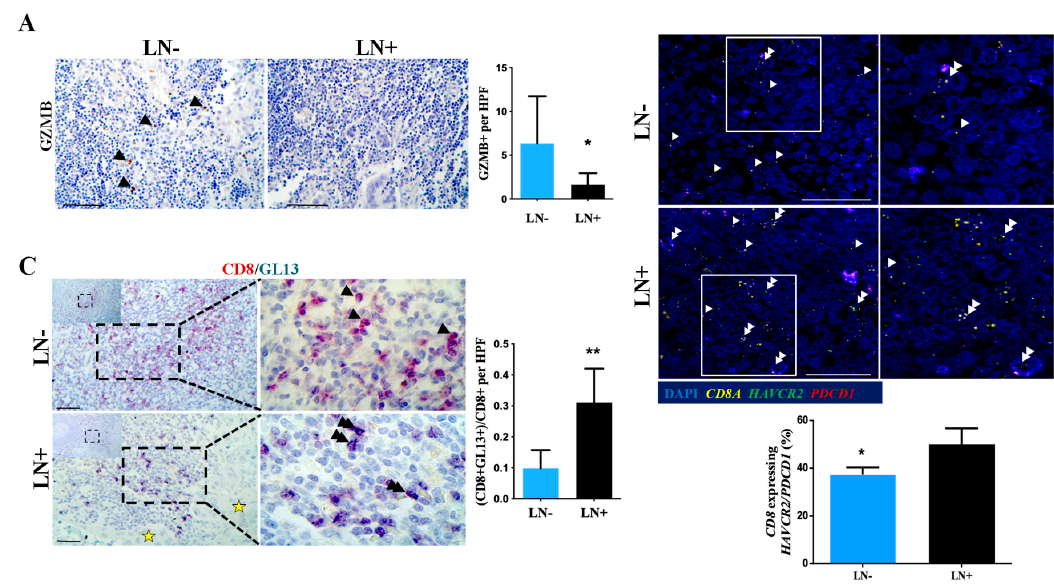
Figure 5. T cells in positive draining lymph nodes exhibit features of T cell exhaustion and senescence. ( A ) Left panel: representative micrograph of GZMB immunohistochemical staining (brown) of non- metastatic (LN-) or metastatic lymph nodes (LN+) from the same patient. Scale bar: 100 μ m. Right panel: quantification of GZMB-positive cells. * p -value < 0.05. Data are expressed as mean ± STDEV (N = 9). ( B ) RNA scope analysis to examine the mRNA expression levels of HAVCR2 (green), PDCD1 (red), and CD8A (yellow) in LN+ and LN-. Upper panel: representative confocal micrographs. Double arrowheads depict CD8A + co-expressing HAVCR2/PDCD1 and single arrowheads demonstrate CD8A + single positive T lymphocytes. Scale bar: 100 μ m. Lower panel: quantification of CD8+ T lymphocytes expressing HAVCR2/PDCD1 mRNA. * p -value < 0.05. Data are expressed as mean ± STDEV (N = 6). ( C ) Co-expression of CD8 (red) and GL13 (emerald) assessed by double immunohistochemistry analysis in non-metastatic (LN-) or metastatic lymph nodes (LN+) from the same patient. Left panel: representative micrograph where double arrowheads depict CD8 and GL13 double positive cells and single arrowheads indicate CD8 single positive T lymphocytes. Scale bar: 100 μ m. Asterisk depicts cancer glands in the metastatic lymph node (LN+). Right panel: quantification of the CD8 and GL13 double positive cells per high power field (HPF, 400× magnification). ** p -value < 0.01. Data are expressed as mean ± STDEV (N = 9).